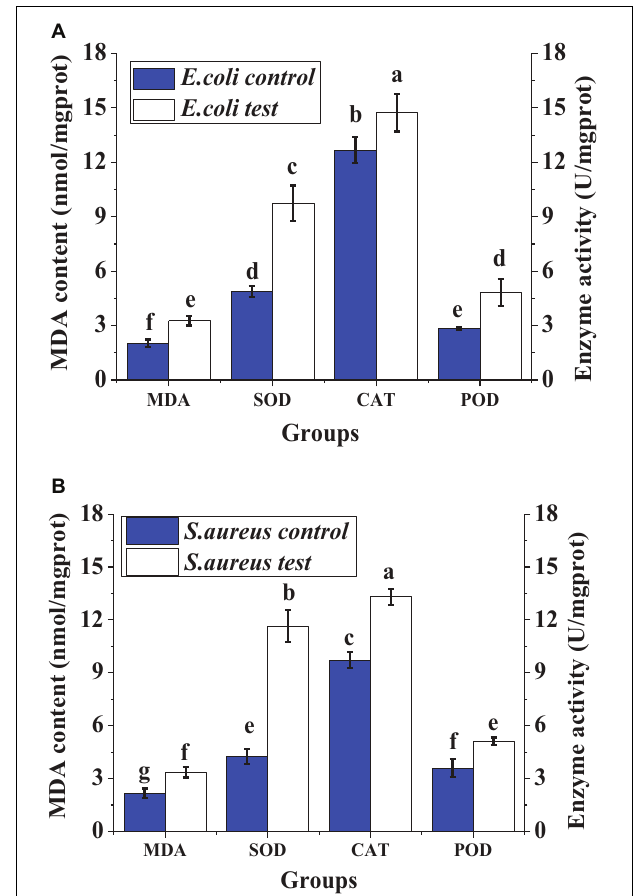
FIGURE 8 | Effect of lacidophilin on intracellular enzymes (SOD, POD and CAT) activity and MDA content of the two indicator bacteria, the S. aureus (A) and the E. coli (B)